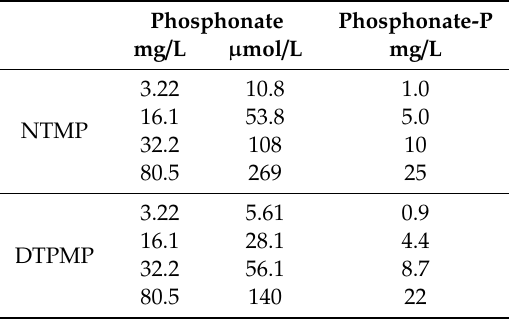
Table 3. Di ff erent concentrations of phosphonates used in Experiment 3. Phosphonate Phosphonate-P mg / L µ mol / L mg /